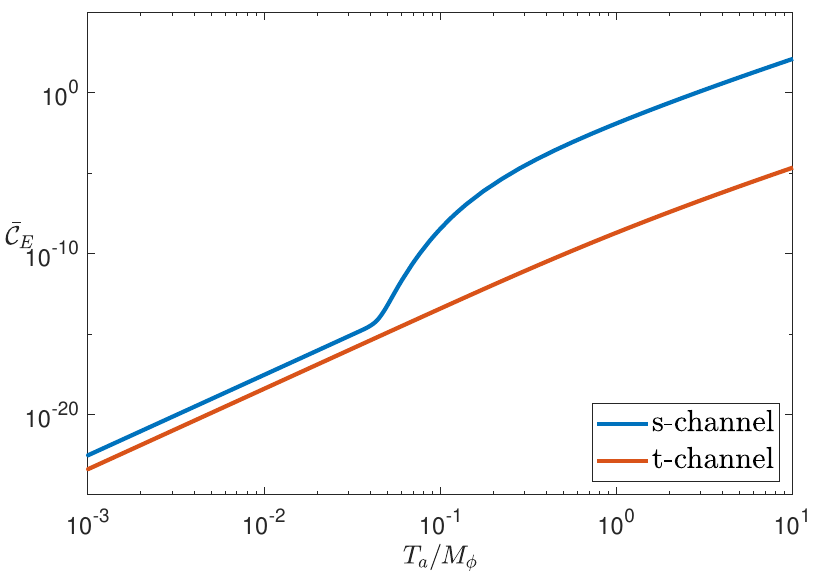
Figure 18. Total collision term C E = C E =M 5 as a function of T a =M (cid:30) at (cid:12)xed x = T b =T a = 0 : 5, (cid:30) for (cid:22) a = 0 : 01 M (cid:30) , k = (cid:22) b = 0 : 5, and m a;b = 10 (cid:0) 8 M (cid:30) and S 0 = 1. The blue line corresponds to the (cid:22) a numerical s -channel contribution to C E of eq. (C.12) with scattering amplitude given by eq. (C.14) while the red line shows the numerical t -channel contribution to C E (eq. (D.18)) with scattering amplitude as given in eq.